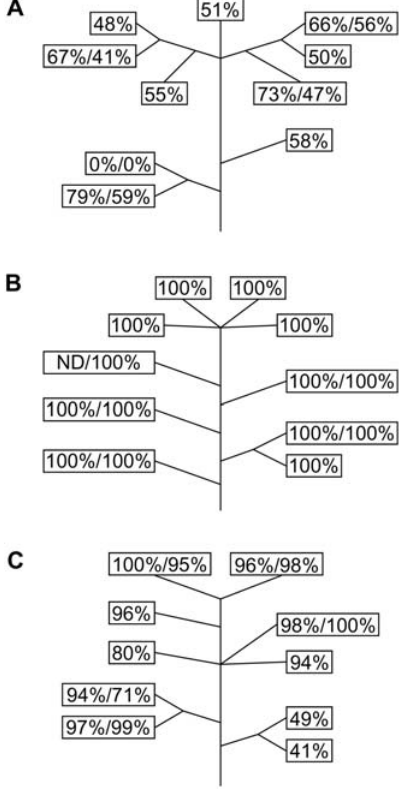
Figure 2. Analysis of instability in homozygous descendents of kr2.3 (A), kr2.7 (B) and kr2.10 (C). Each box represents a seed capsule. Where one number is shown, it indicates the percentage of kanamycin resistant progeny from a backcross to male wildtype. Where two numbers are shown, that flower was used for both self-fertilisation and backcrossing to female wildtype. The numbers indicate the percentage of kanamycin resistant progeny from self-fertilisation and backcrossing respectively. Each number represents approximately 100– 150 seeds which were tested for kanamycin resistance. Lines represent branches (not to scale) and are included to show the branching pattern of the plants from which individual seed capsules were progeny tested. ND not determined.